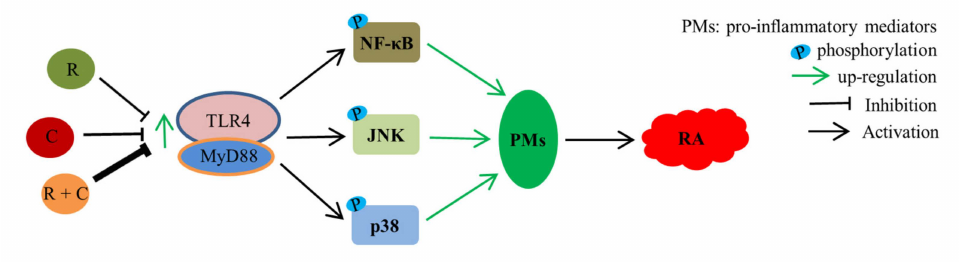
Figure 8. The signaling pathways that rosmanol (R), carnosol (C), and their combination (R + C) target in RA. The intensity of inhibition is proportional to the line width of the inhibition symbol.